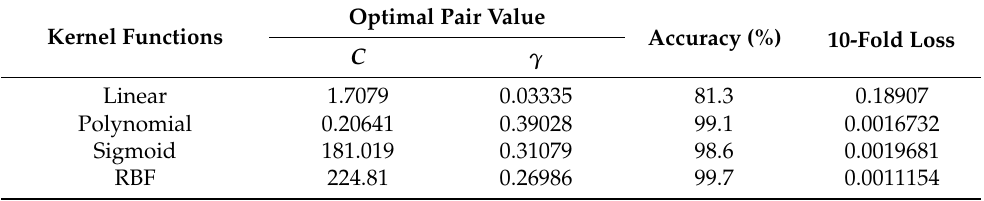
Table 2. Optimal pair value of four SVM